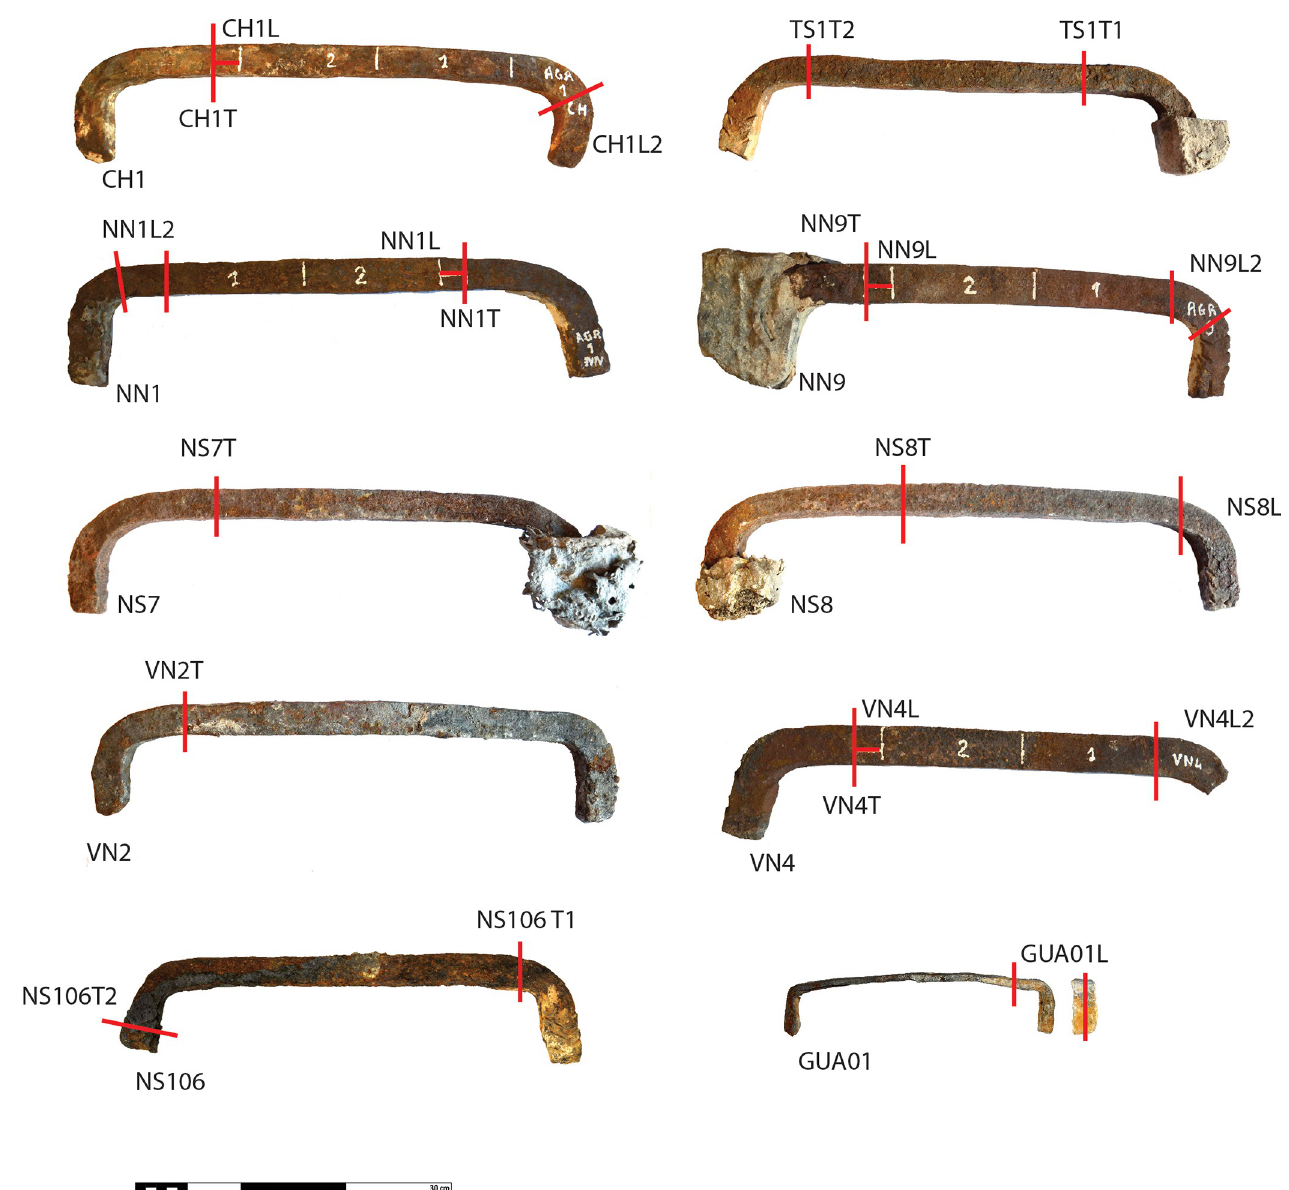
Fig 7. Sampling on the studied